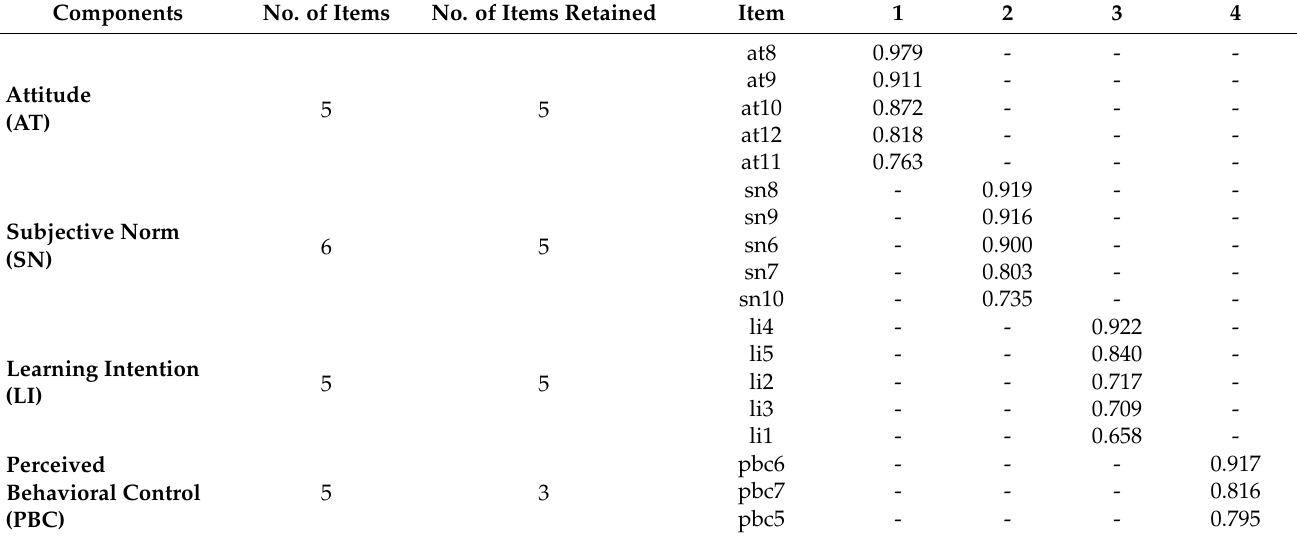
Table 3. Factor loadings for variables.